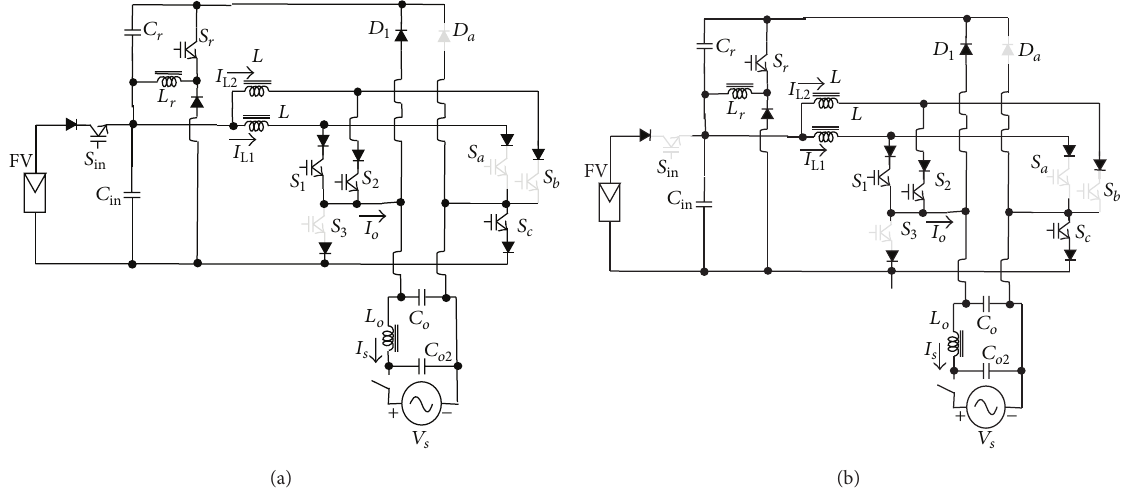
Figure 6: Subcircuit when the protection circuit is operating for positive